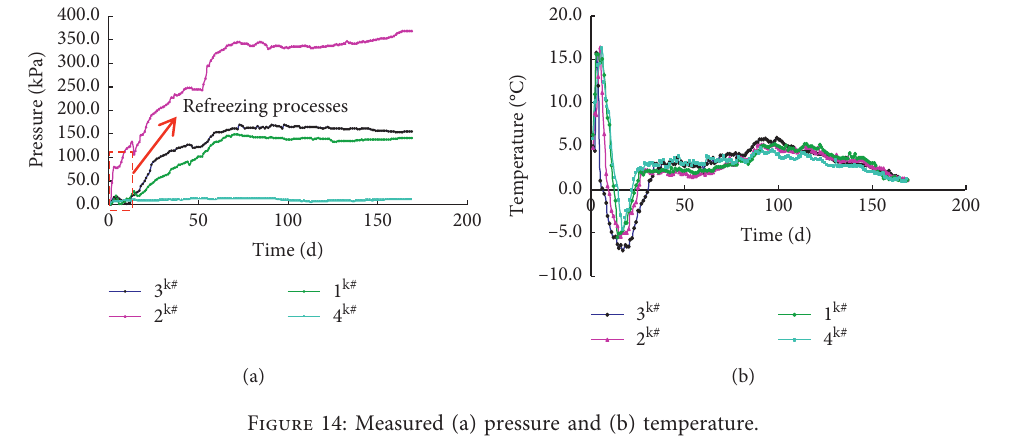
Figure 14: Measured (a) pressure and (b) temperature.